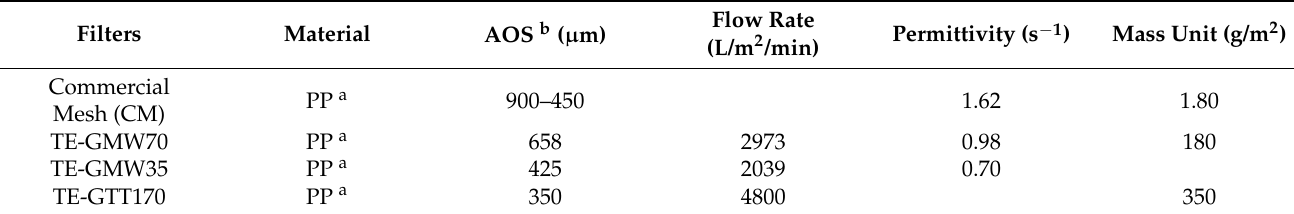
Table 1. Non-woven, woven geotextiles and mesh characteristics used in this study.